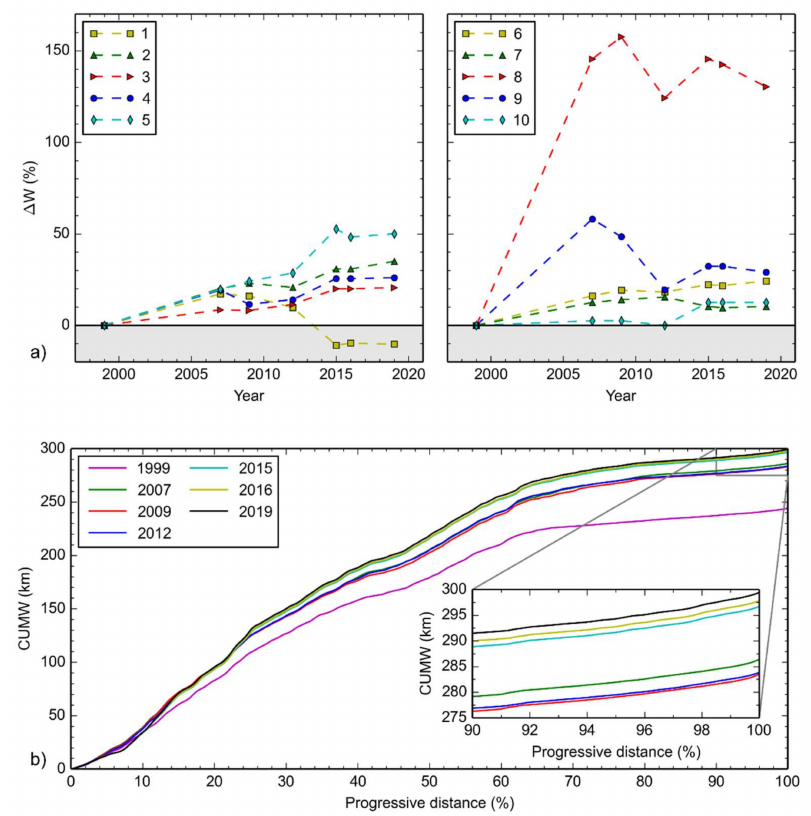
Figure 5. Active channel width changes; ( a ) Variations expressed by using the ∆ W% parameter for reaches 1 to 5 and 6 to 10; increasing (decreasing) trend indicates widening (narrowing); ( b ) Cumulative active-channel width (CUMW) plotted against progressive distance. Steep slopes represent abrupt active channel width increase; moderate slopes indicate river stretches with a wide active channel; gentle slopes represent river stretches with a narrow active